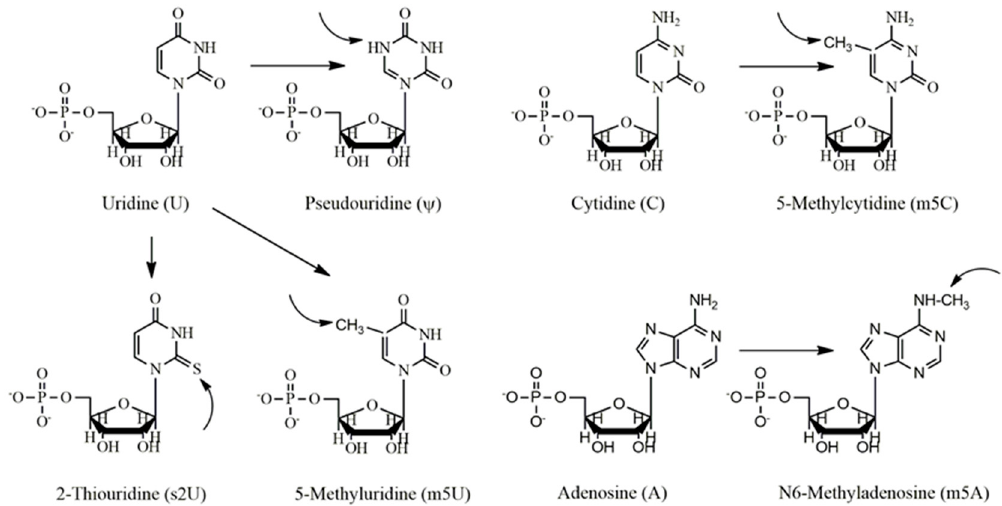
Figure 2. Nucleoside bases usually modified in the vaccination process. Uridine (U) is generally modified to pseudouridine ( ψ ), 2-thiouridine (s2U) and 5-methyluridine, cytidine (C) to 5-methylcytidine, and adenosine (A) to 5-methyladenosine (m5A).